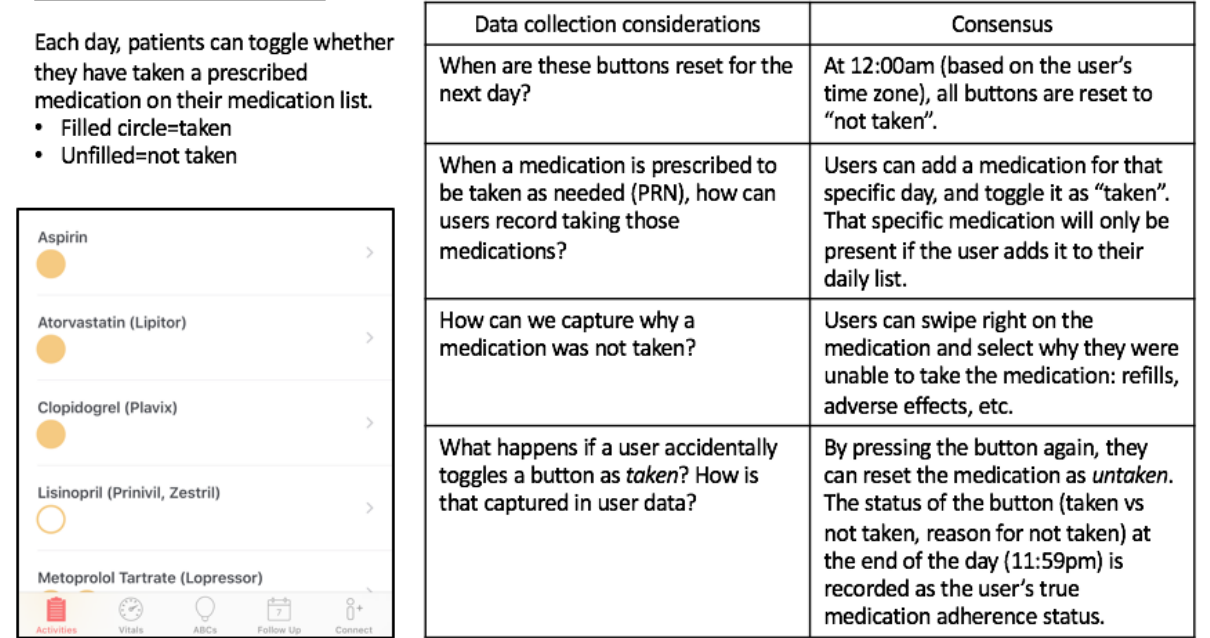
Figure 2. An example of data collection and product considerations when developing a new